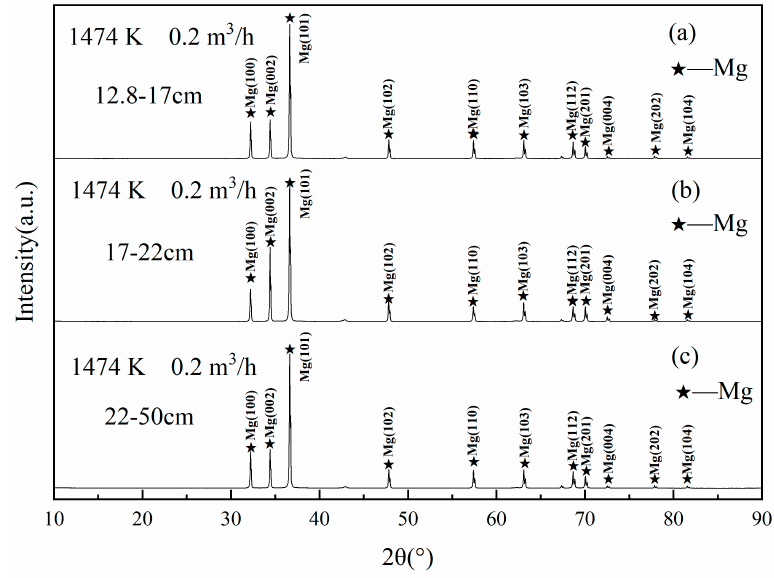
Figure 8. XRD analysis of magnesium condensation at different positions (1473 K heating and 0.2 m 3 /h Ar): ( a ) Mg product at 12.8–18 cm, ( b ) Mg product at 17–22 cm, ( c ) Mg product at 22–50 cm.